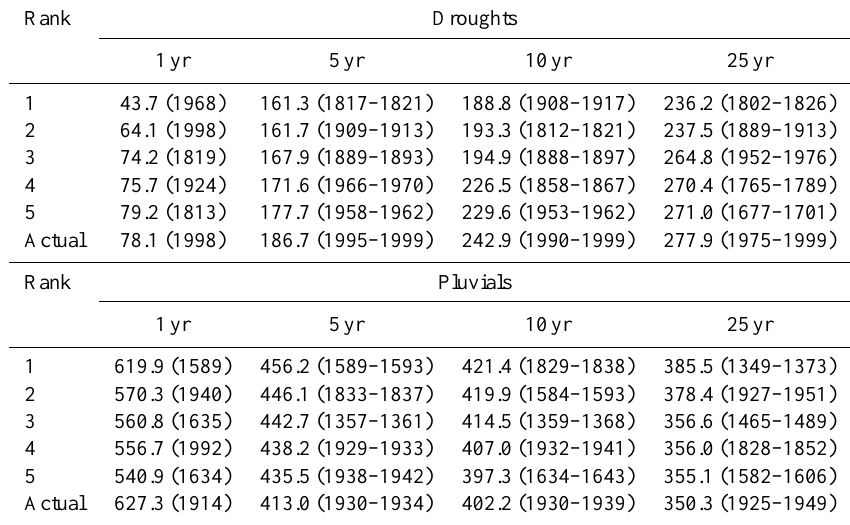
Table 3. Lowest and highest n year moving averages of the reconstructed (1346–2000) and measured streamflow (1903–2009). Events are non-overlapping averages of the mean October–June Neuqu´en River streamflow (m 3 s − 1 ) for n year periods. Ranks 1–5 are the most severe reconstructed events and actual is the most severe observed event.